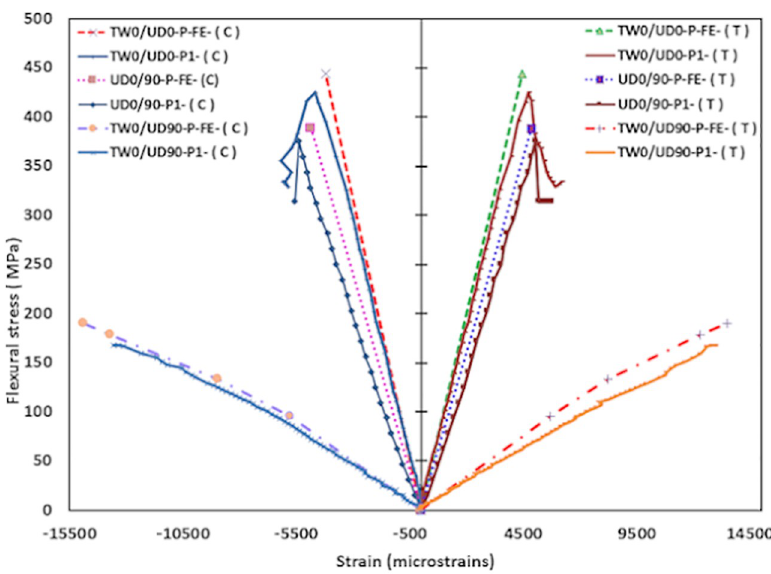
Fig 10. Flexural stress-strain behavior for SHC beams containing pre-existing 10 mm transverse skin crack at the compression side.